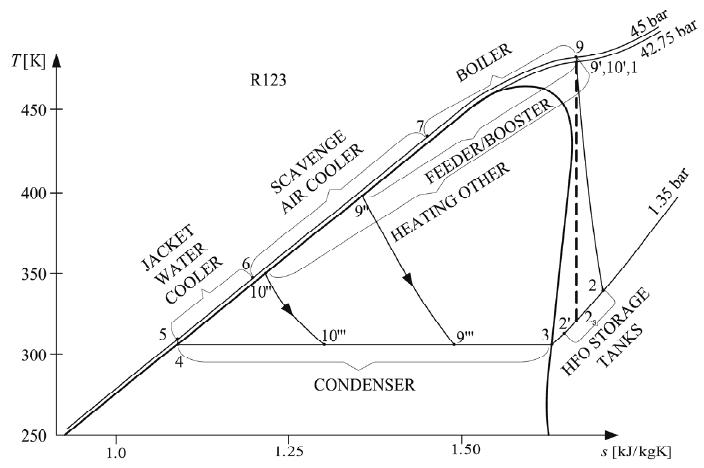
Figure 6. T-s diagram for the ORC CHP Plant with R245fa fluid [5,15].